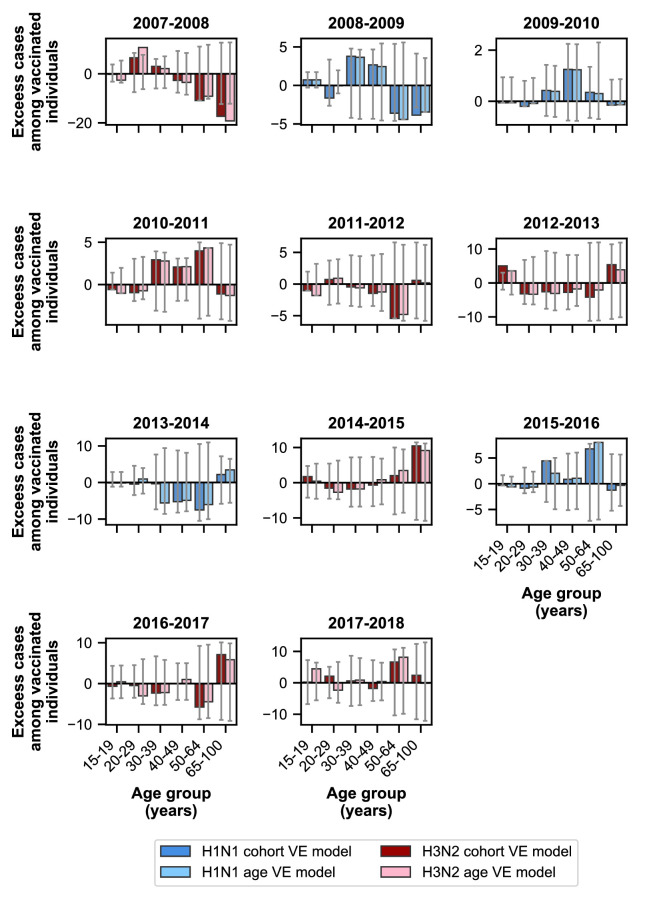
Excess cases for models using birth-cohort-specific VE and age-specific VE.The birth-cohort-specific VE model predicts observed cases better than the age-specific VE model for people ≥15 years old. Bars show the excess cases in vaccinated individuals relative to the birth-cohort-specific VE model (dark colors) and the age-specific VE model (light colors) for age groups ≥15 years old. Colors indicate the dominant subtype of a given season. 95% prediction intervals are shown as grey error bars.